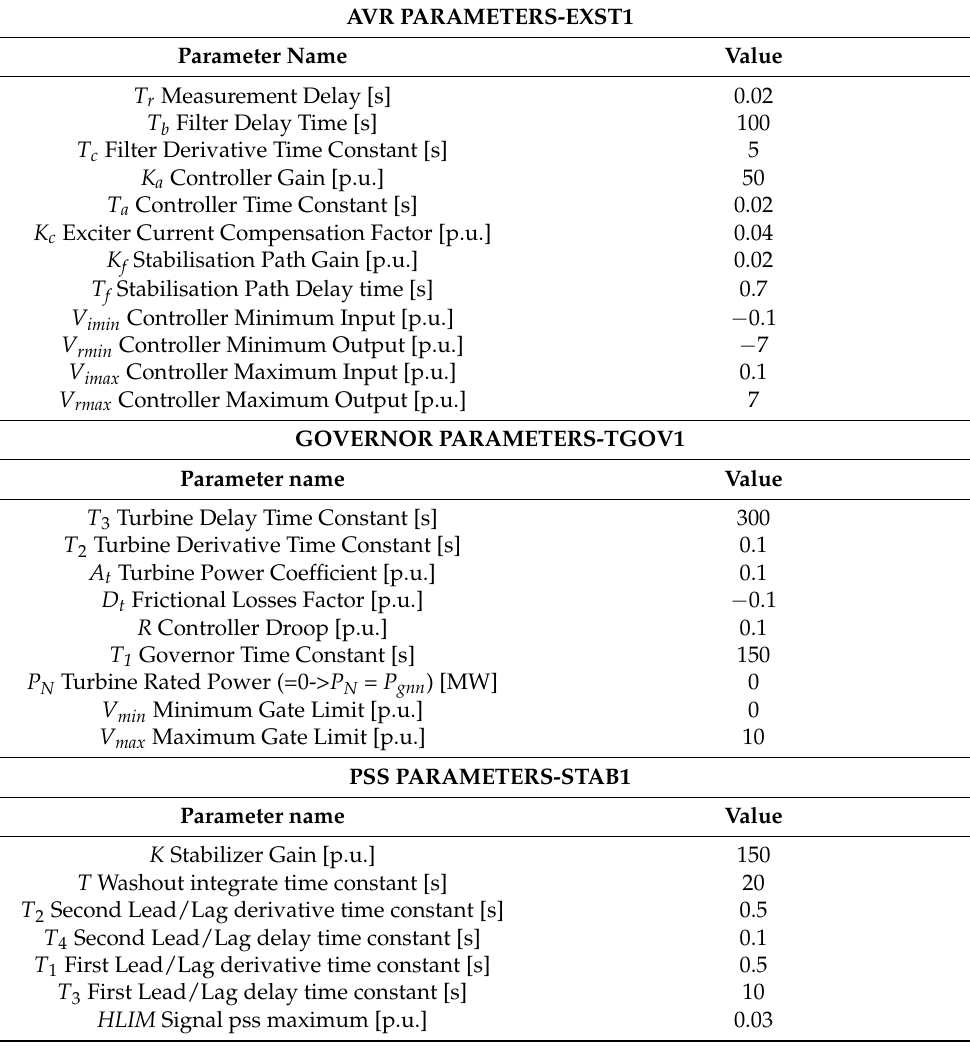
Figure 6. Updated substation layout representing a single zone of the reduced model. Table 1. Modified IEEE controller settings for the reduced model AVR, GOV, and PSS.